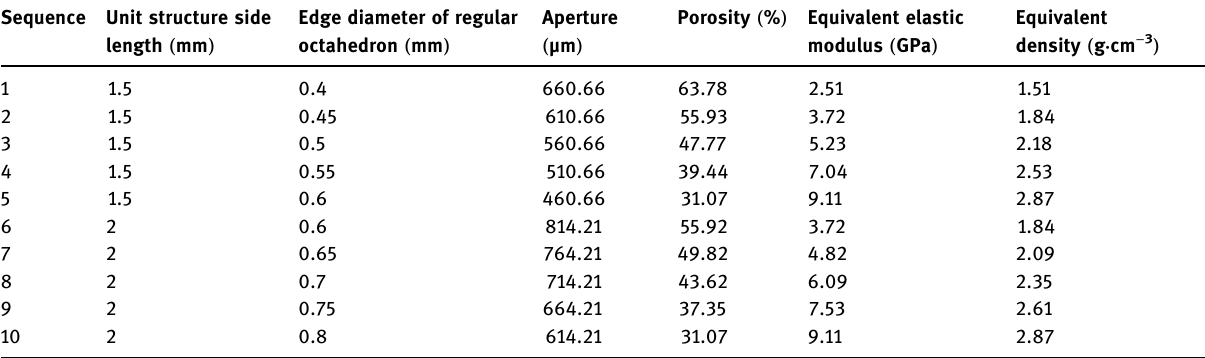
Table 2: Structural design parameters of regular octahedral porous structure Sequence Unit structure side